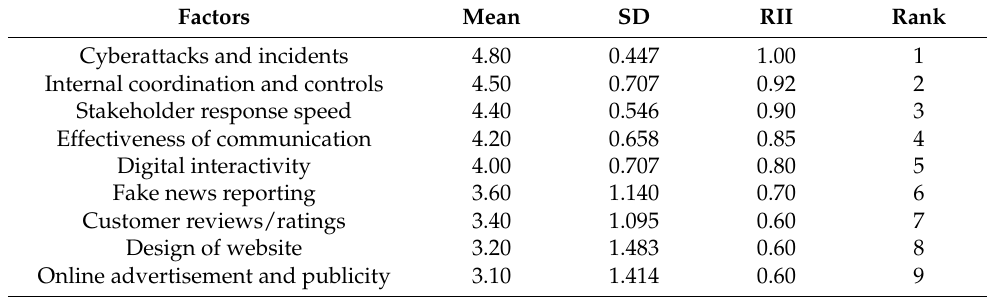
Table 6. Classification under process.